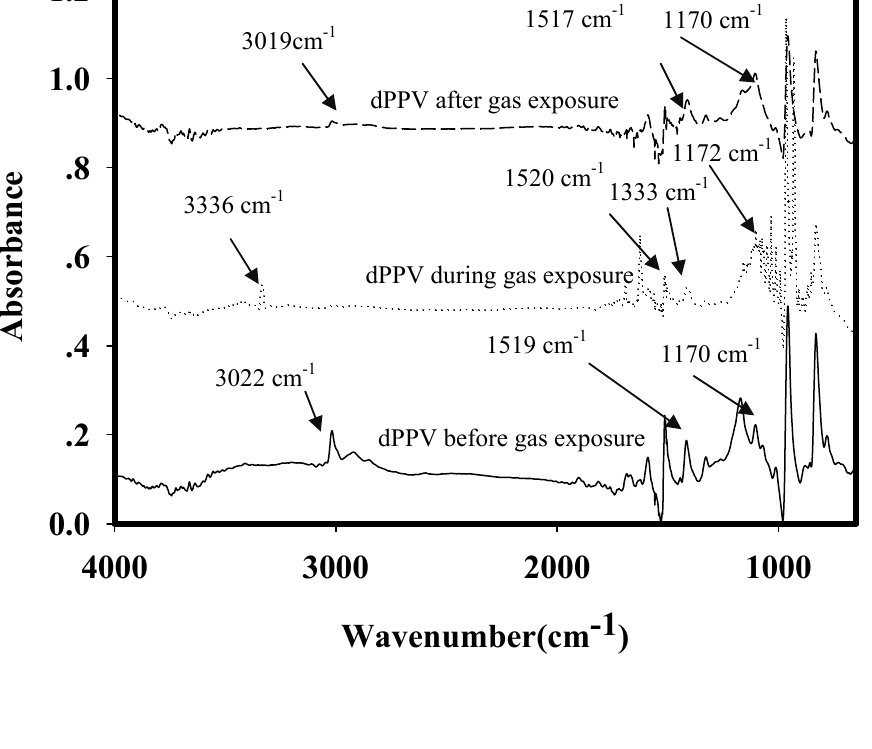
NO (NH NO = 377 ppm, pressure 4 3 4 3